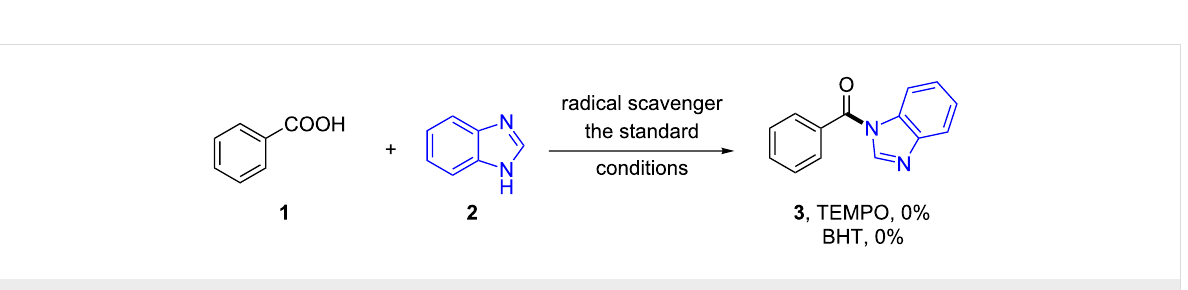
Scheme 7: Radical scavenger